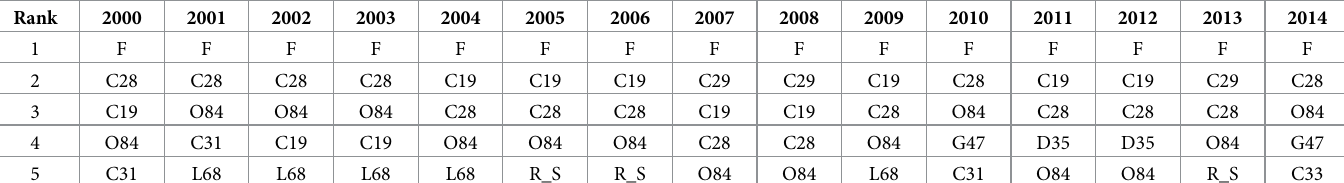
Table 6. Five lowest-potential sectors in European community. Rank